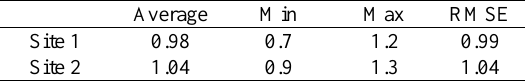
Table 3. Registration Error